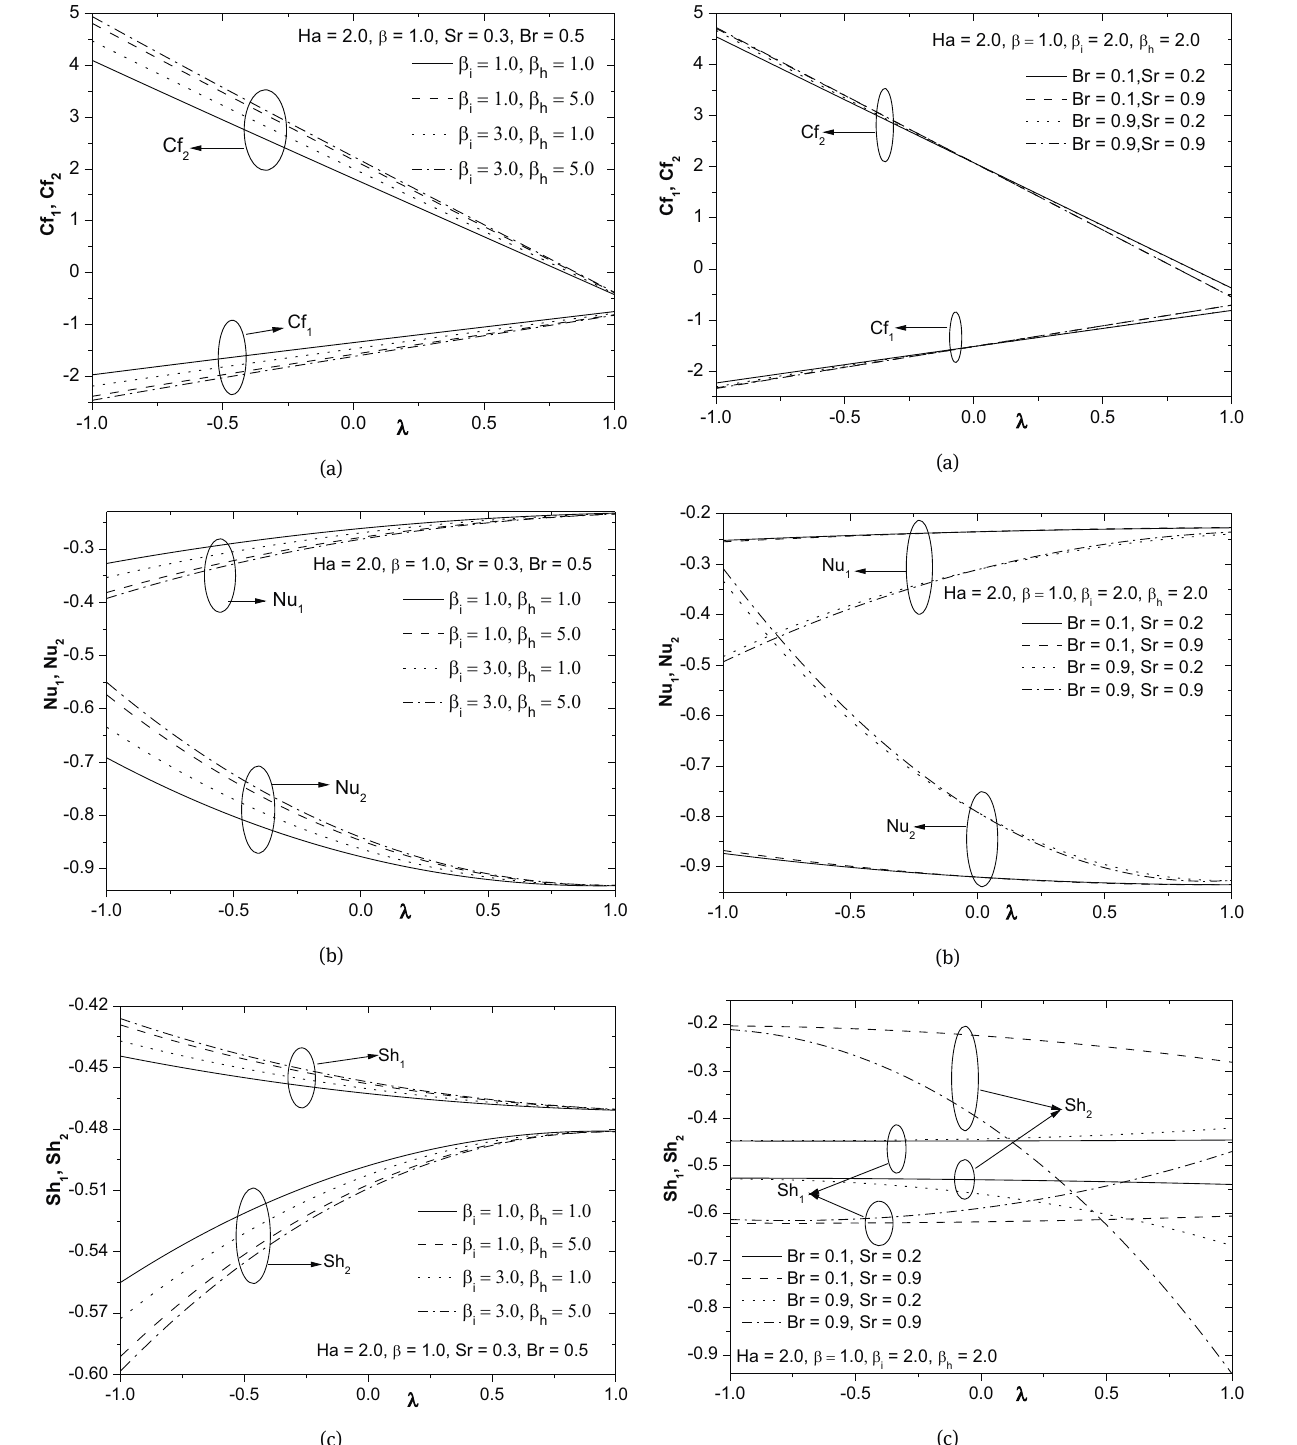
Fig. 6: Effect of Br and Sr on (a)skin friction, (b)heat transfer rate, (c)mass transfer rate profiles both the walls of the